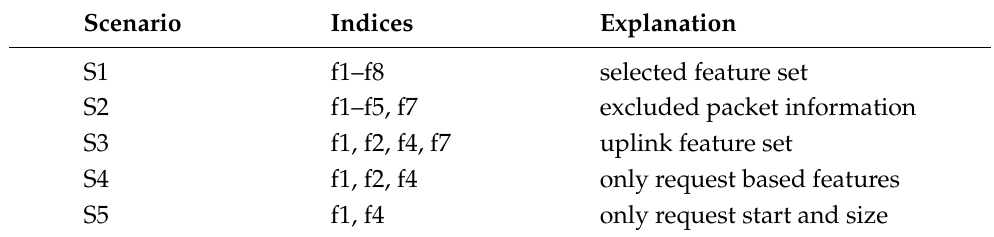
Table A2. Feature